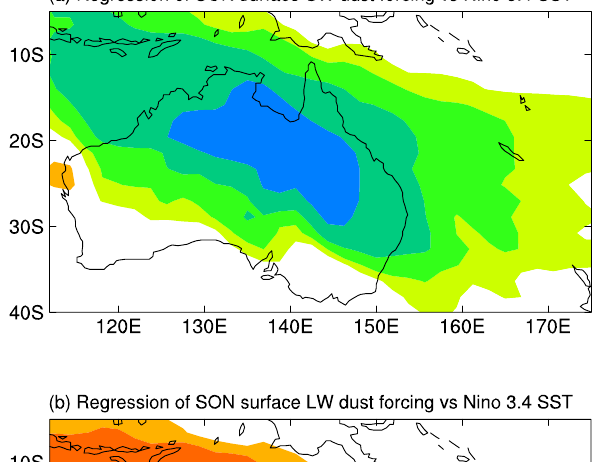
Fig. 11. Difference of the regression slopes of surface evapora- tion versus Ni˜no3.4 SST between the DUST and NODUST runs for SON (shading, in mm per day per Kelvin). Streamlines show the mean SON 850-hPa flow in the DUST